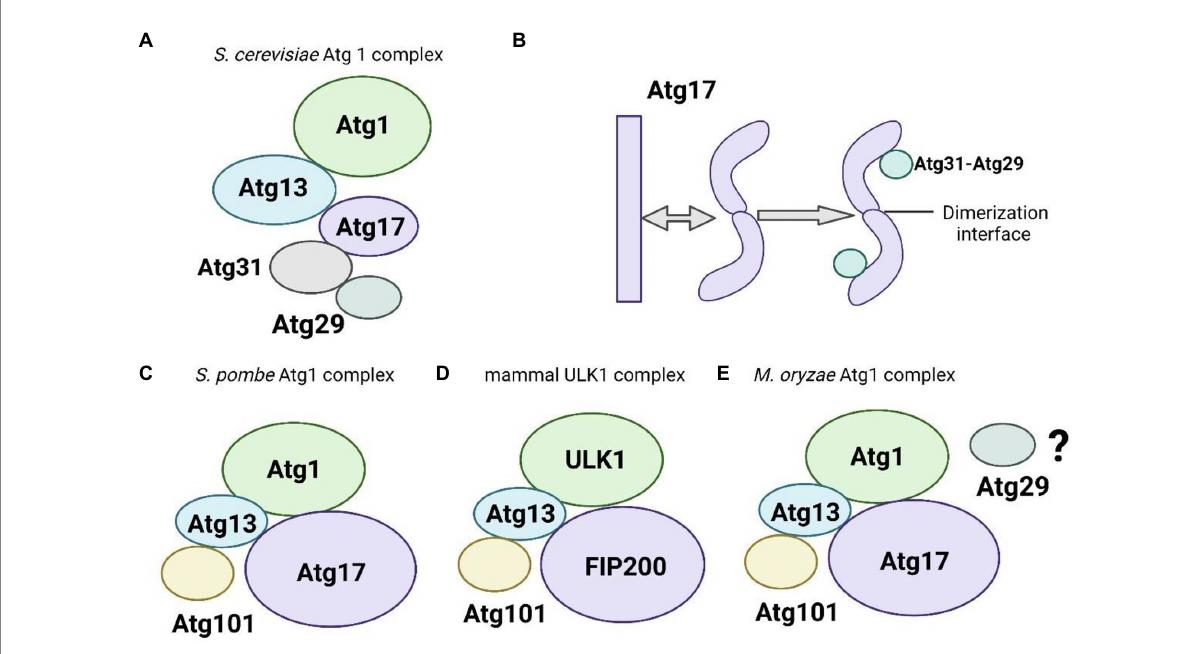
FIGURE 1 Schematic of the components of the Atg1/ULK1 complex. ( A) The budding yeast Saccharomyces cerevisiae Atg1 complex components. (B) Components of the S. cerevisiae Atg17-Atg31-Atg29 complex with the depicted two smaller components Atg29 and Atg31 stabilizing the unique curvature of Atg17. (C) The fission yeast Atg1 complex components (D) . Mammalian ULK1 complex components. (E) The M. oryzae Atg1 complex